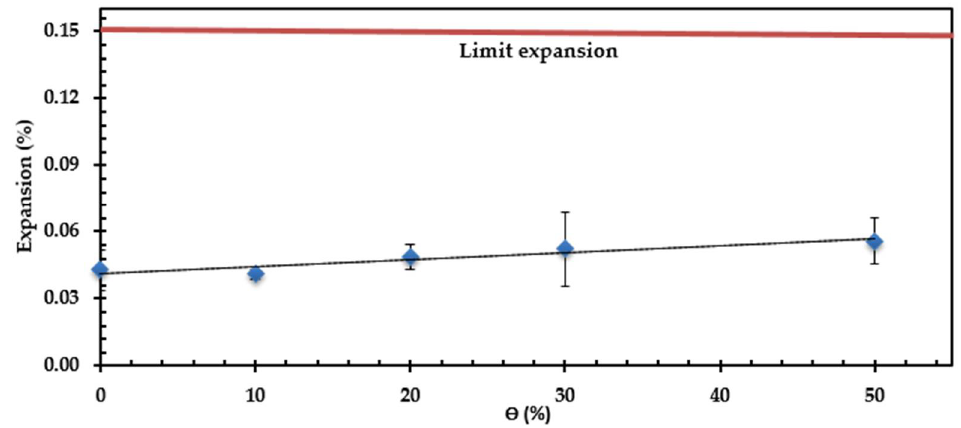
Figure 11. Expansion of different mortar-based composites reinforced with different volume contents of RWG, compared to limit expansion value of 0.15%.